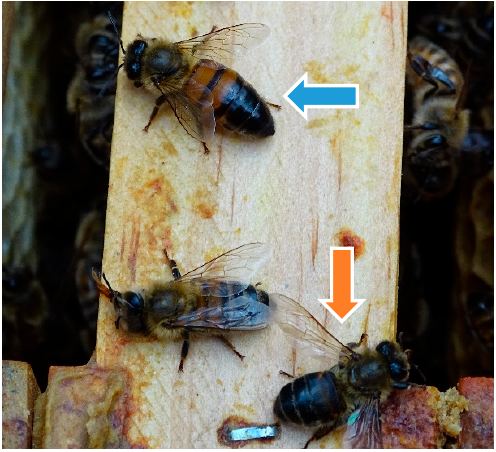
Figure 3. Clinical examination of colony 1: worker bee with hairless, “black” abdomen (blue arrow); worker bee with ant-like phenotype (orange arrow), ©Julia Dittes.